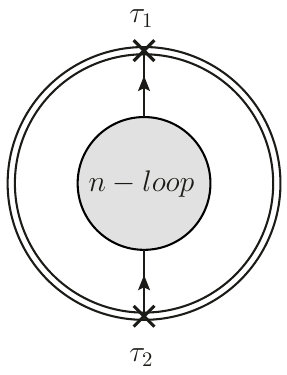
Figure 5 . The contribution to the two-point function of the scalar partner of the displacement operator arising from the n -loop correction of the scalar